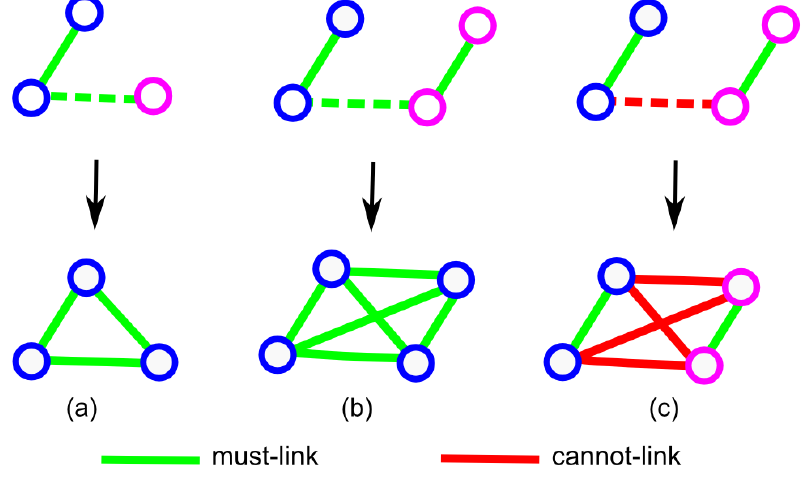
Figure 4. Constraint augmentation process. A solid line represents a previously known constraint, and a dotted line represents a newly added